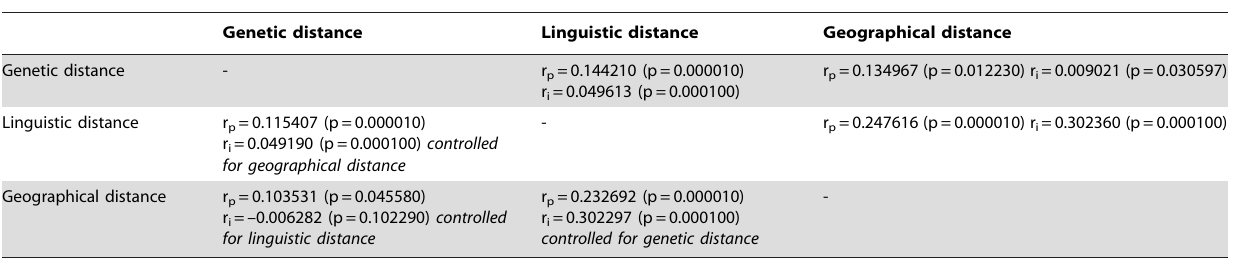
Table 3. Summary of Mantel tests in zt.